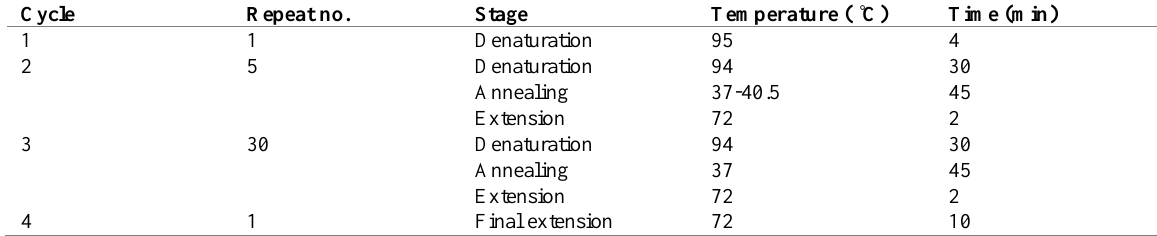
Table 4. Time and temperature needed for three steps (denaturation, annealing, and extension) in each of the PCR